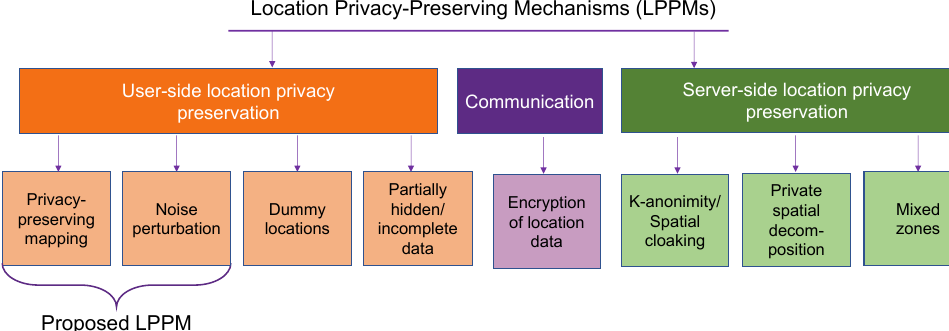
Figure 1. Three-fold classification of location-privacy mechanisms: starting from the edge device, a.k.a. user side (including two parts of the proposed privacy-preserving technique), communication part used for transferring data packets, and server-side perspective including the cases where the users’ data is aggregated on the server.